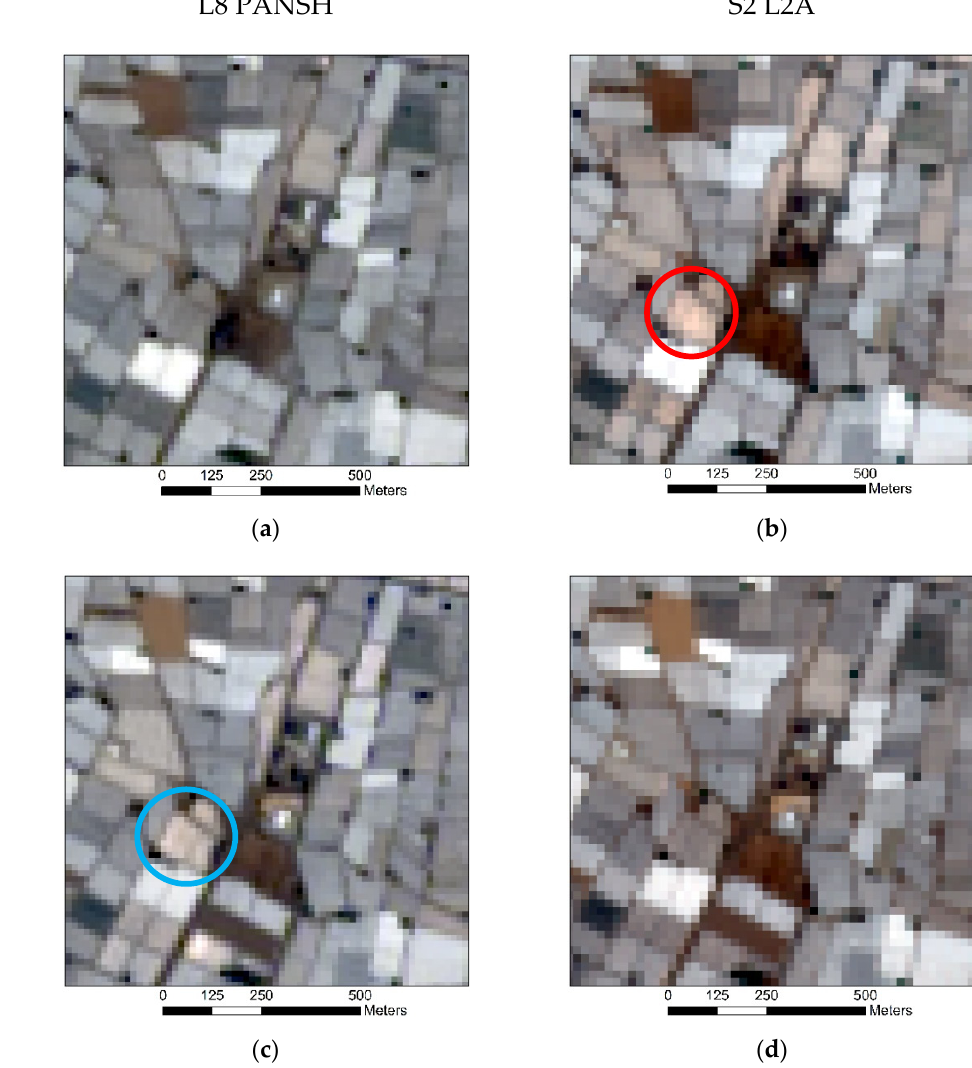
Figure 9. Sun glint effect over greenhouses in SS1 corresponding to a detailed area (1000 m × 1000 m) of the simultaneous RGB scenes taken on June 18 (first row) and June 25 (second row), 2019 in SS1: ( a ) L8 PANSH, June, 18 (R: 36.84 to 33.88 (34.91), G: 33.08 to 30.09 (31.38), B: 29.11 to 26.41 (27.37)); ( b ) S2 L2A, June, 18 (R: 68.37 to 58.18 (63.43), G: 56.29 to 50.59 (52.34), B: 47.91 to 43.67 (45.38)); ( c ) L8 PANSH, June, 25 (R: 60.22 to 51.25 (53.58), G: 50.97 to 43.35 (45.12), B: 43.22 to 34.45 (36.64)); ( d ) S2 L2A, June, 25 (R: 46.01 to 42.01 (43.43), G: 41.95 to 38.65 (40.03), B: 38.90 to 35.93 (36.97)). The red and blue circles point to a greenhouse showing a high glint effect (also marked in the same colors in Figure 10). The range (maximum to minimum) and the mean values (in brackets) of reflectance (%) for RGB in the marked greenhouse are shown.